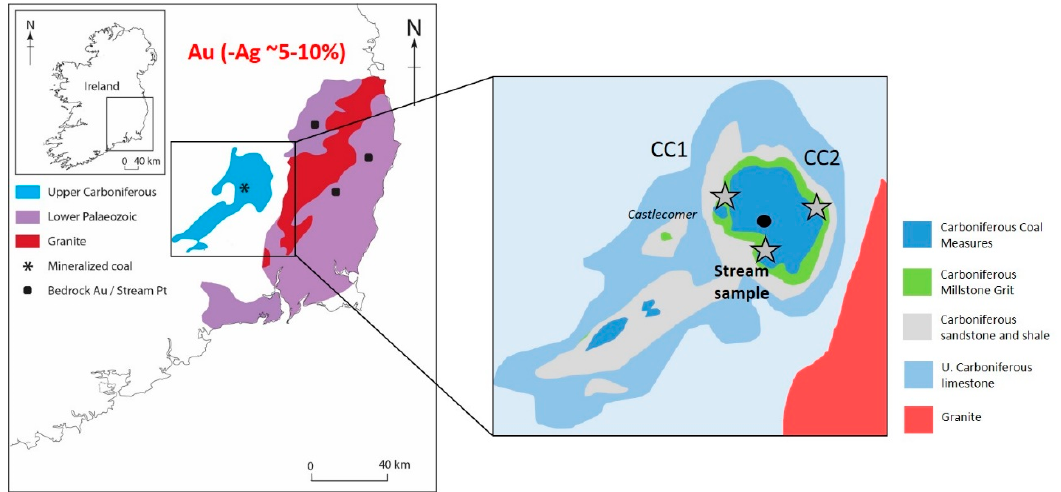
Figure 1. Location of the Castlecomer Plateau and Upper Carboniferous coal region, west of known gold-hosting Lower Palaeozoic bedrock and gold–platinum-rich stream sediment localities. Gold-mineralised Irish Caledonides (containing both gold and silver, red text indicating the percentage of silver comprising the alloy [29]) were exposed and eroded into the sedimentary succession in advance of coal deposition—The provenance of Carboniferous rocks is dominated by this basement material. The sampling localities are indicated by grey stars.